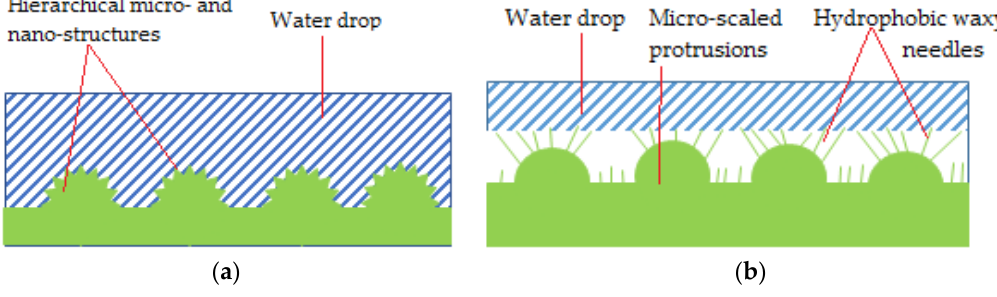
Figure 4. Petal surface structure (Cassie impregnating wetting state) ( a ) and Lotus leaf surface structure (Cassie state) ( b ).